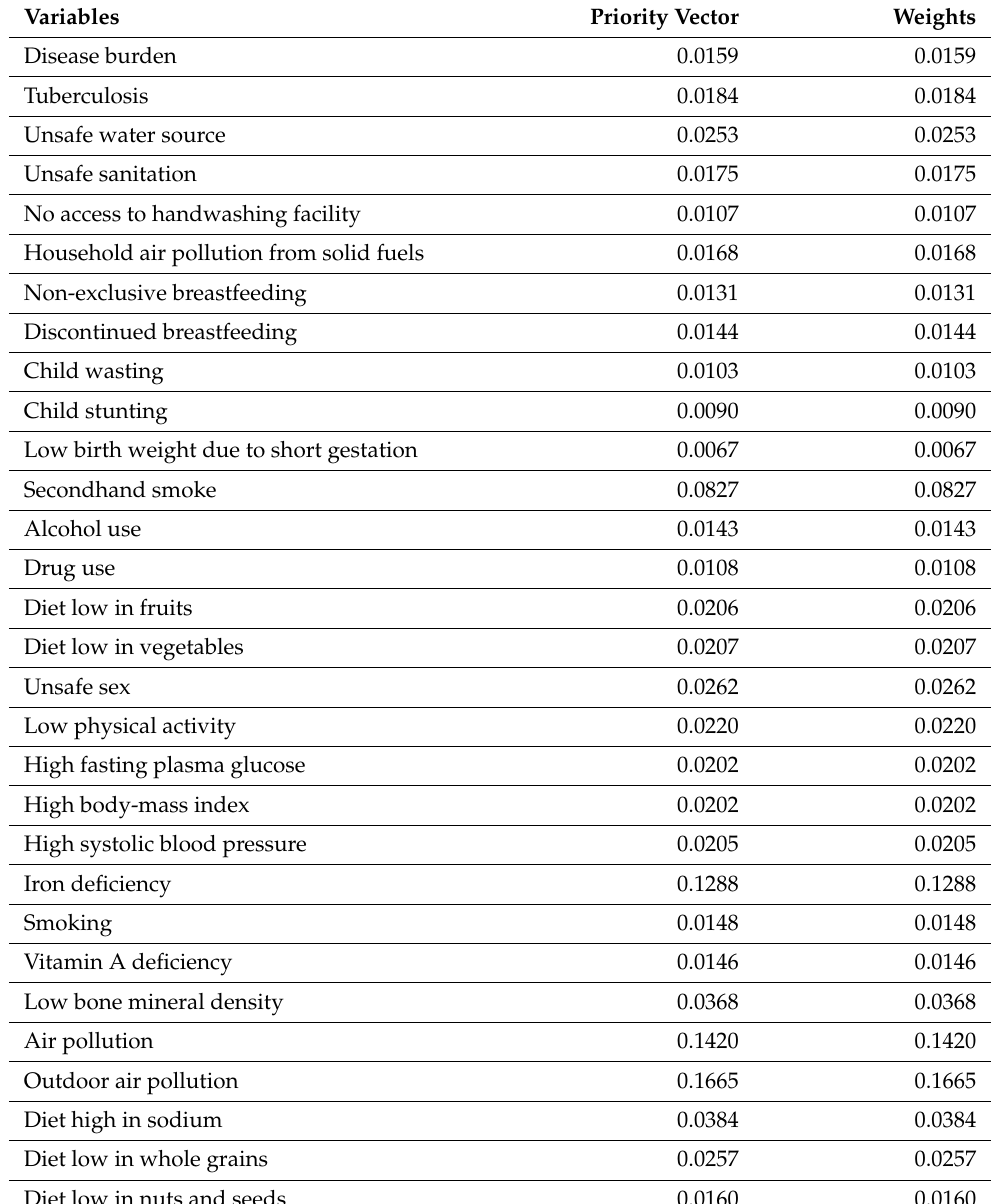
Table 7. Results of the AHP